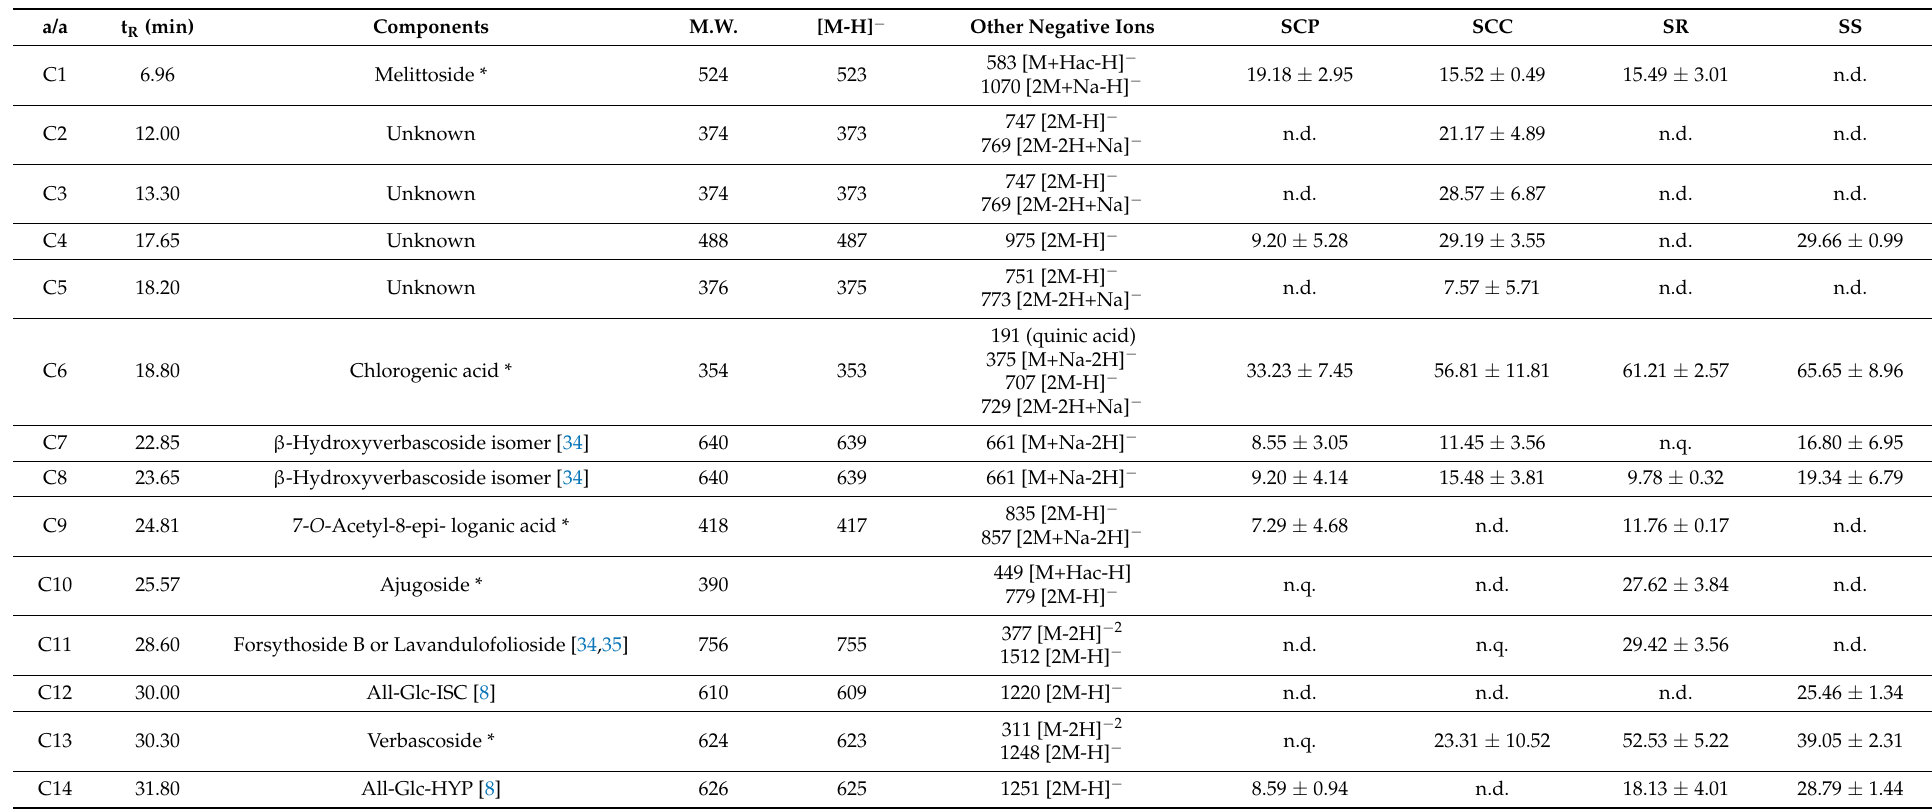
Table 1. List of polar metabolites and their concentrations (mg rutin equivalents/100 g of dry plant material, average values ± standard deviation) in Sideritis clandestina subsp. peloponnesiaca (SCP), Sideritis clandestina subsp. clandestina (SCC), Sideritis raeseri (SR), and Sideritis scardica (SS) aqueous extracts (2 biological samples, n = 2 for each